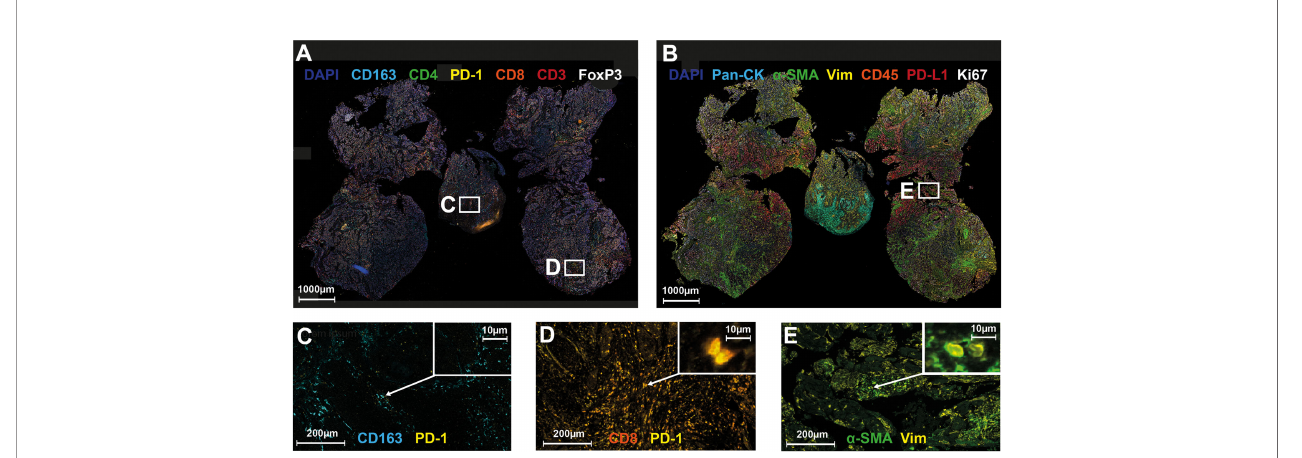
FIGURE 4 | Multiplex Immunohistochemistry and Cell Types Associated with Poor Response to Neoadjuvant Chemoradiotherapy. Representative overview of the T- cell antibody panel (A) and the TME panel (B) , and exemplary images of cell types with association to tumor response to neoadjuvant chemoradiotherapy (C – E) . Nuclei were counterstained with DAPI (blue). (A) T-cell panel: CD163 (cyan), CD4 (green), PD-1 (yellow), CD8 (orange), CD3 (red), FoxP3 (white); (B) TME panel: Pan- CK (cyan), aSMA (green), Vimentin (yellow), CD45 (orange), PD-L1 (red), Ki67 (white); (C) PD-1 positive macrophage; (D) PD-1 positive cytotoxic T-cell; (E) Cancer- associated fi